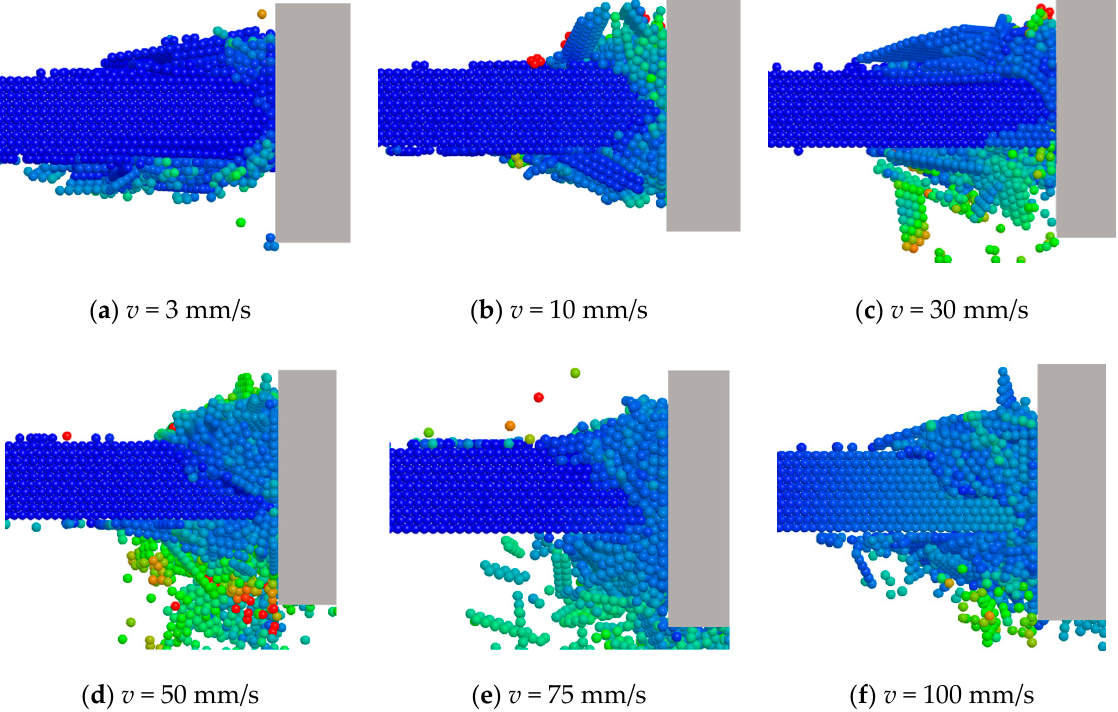
Figure 13. Failure process of sea ice under different loading rates.